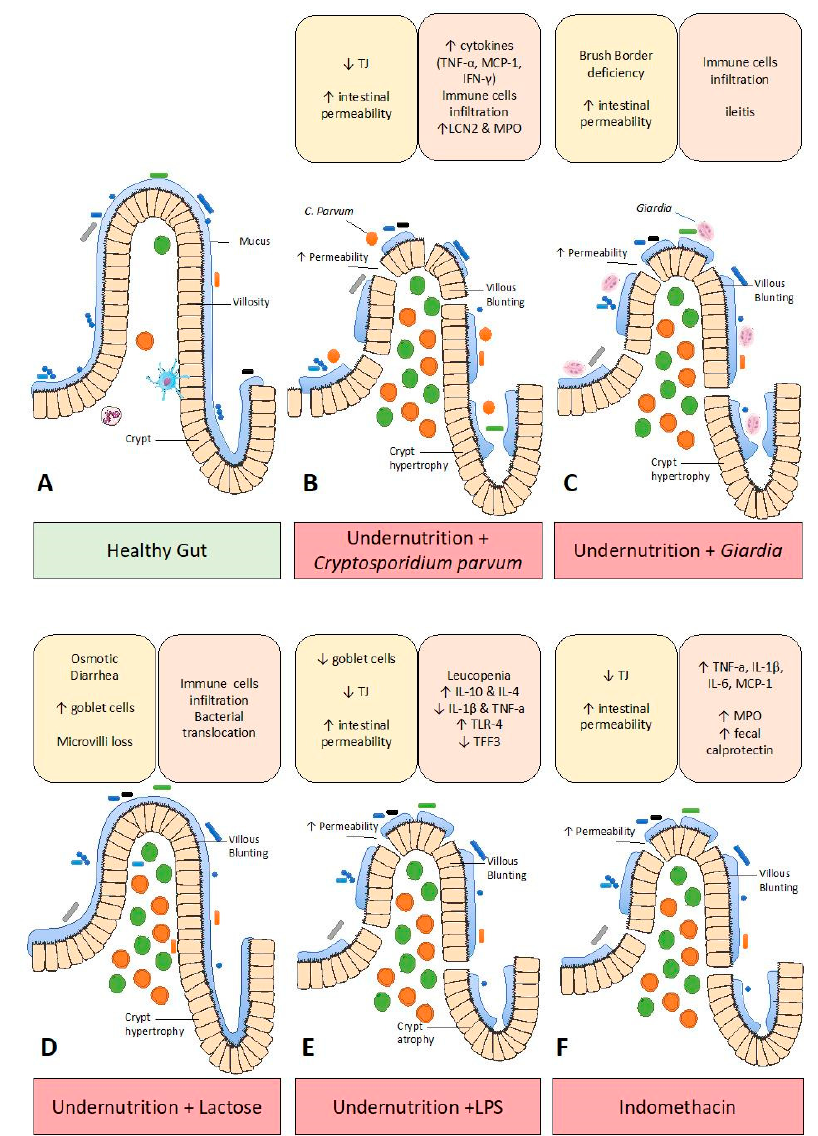
Figure 1. Experimental models of undernutrition and / or enteropathy and their respective impact on gut barrier function (yellow box) and inflammation (orange box). ( A ) Healthy gut. ( B ) Combination of undernutrition with Cryptosporidium parvum infection induced higher intestinal permeability, lower tight junction protein levels, villous blunting, crypt hyperplasia and inflammation. ( C ) Giardia infection induced intestinal hyperpermeability, villous blunting, crypt hyperplasia, ileal inflammation and immune cell infiltration. ( D ) Lactose-induced enteropathy induced villous blunting, increased goblet cells number, osmotic diarrhea, immune cell infiltration and bacterial translocation. ( E ) LPS- enteropathy in undernourished mice induced intestinal hyperpermeability and lower tight junction levels, fewer goblets. ( F ) Indomethacin-induced enteropathy led to intestinal hyperpermeability and intestinal